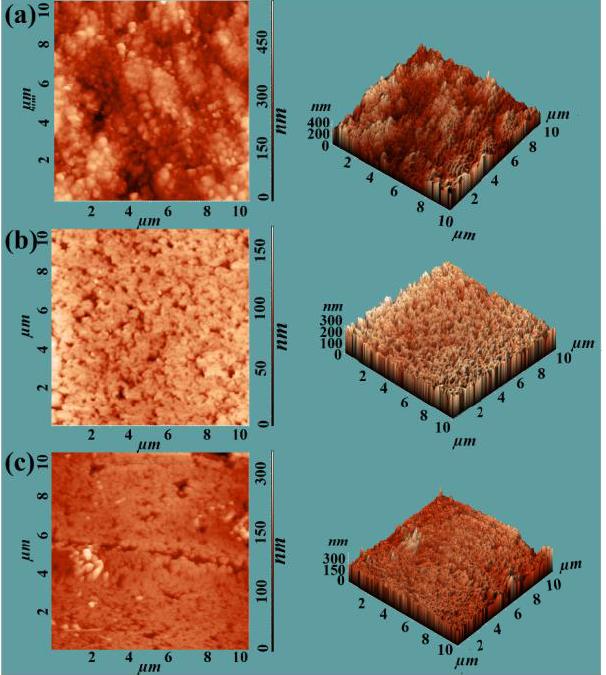
Figure 16. Atomic force micrograph 2D views (left) and respective 3D views (right) of ( a ) chloromethy- lated polystyrene PS–Cl, ( b ) [V IV O(acac)L 1 ]@PS ( 3 ) and ( c ) [V IV O(acac)L 1 ]@PS ( 4